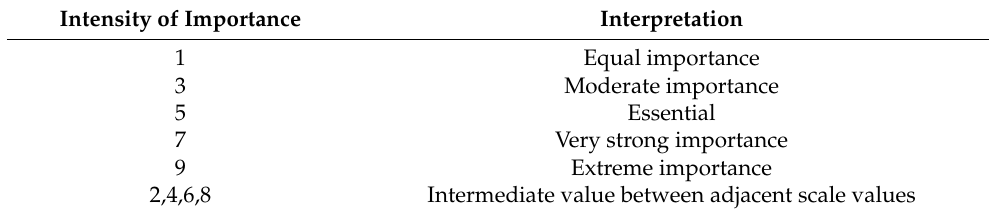
Table 2. Saaty’s 1-9 scale of relative importance [62].